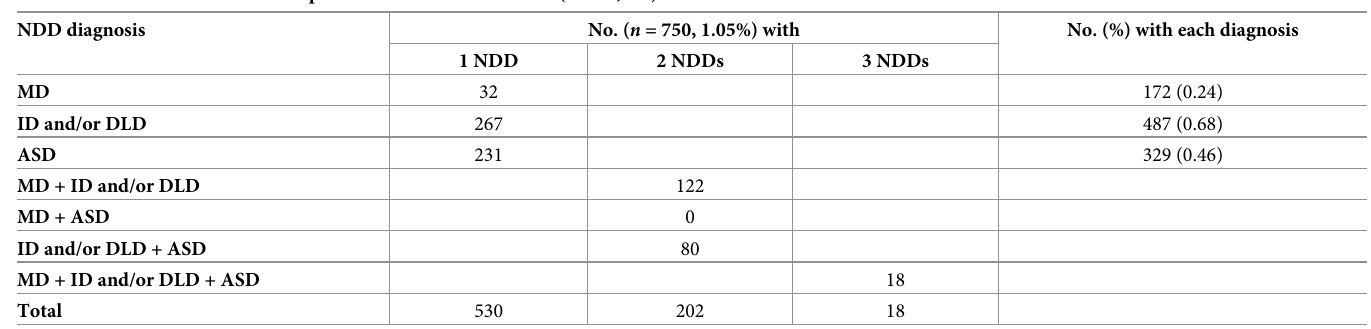
Table 2. Prevalence of neurodevelopmental disorders in children ( n = 71,682).